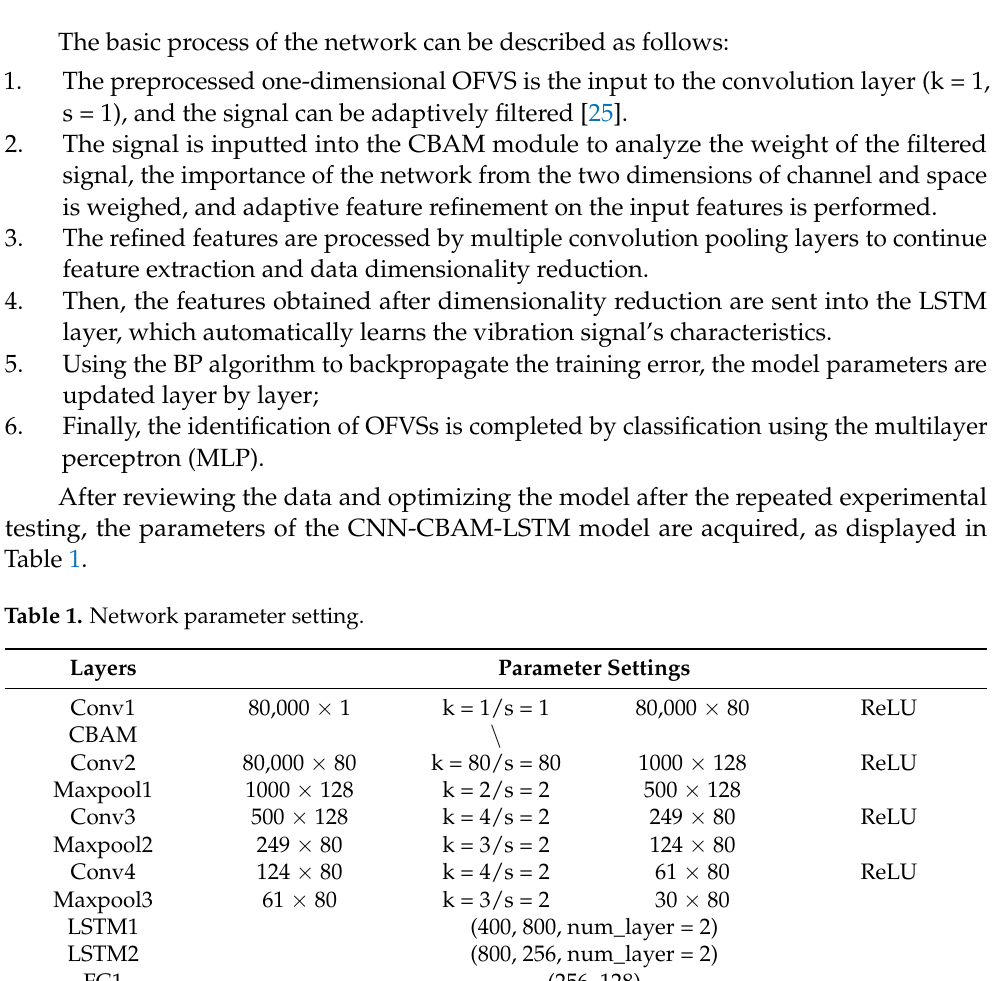
Figure 8. One-dimensional CNN-CBAM-LSTM network structure.